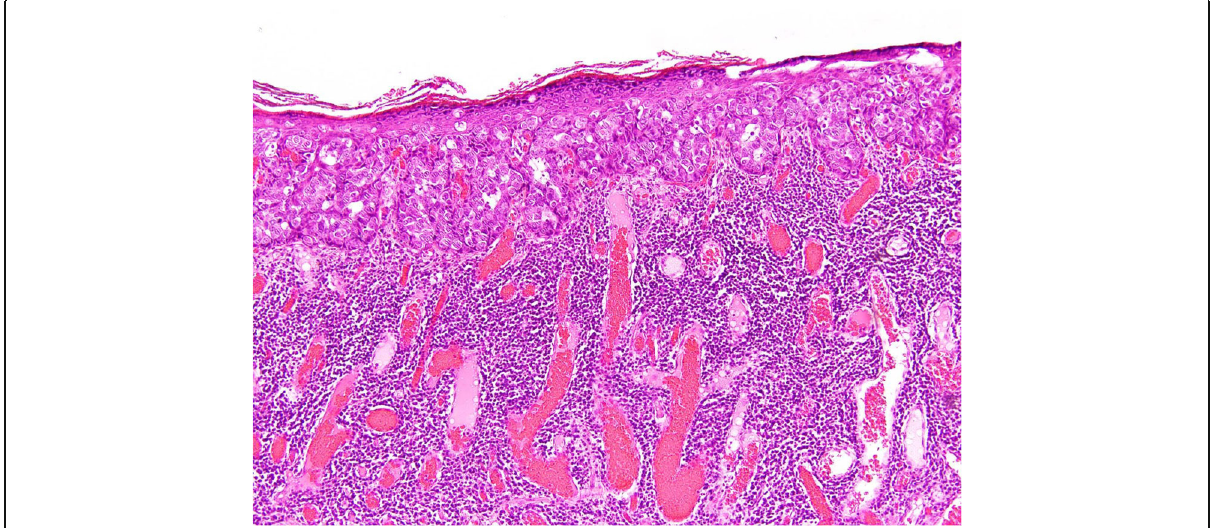
Fig. 4 Histological findings of the resected specimen (original magnification, × 10). Characteristic Paget cells were detected within the epidermis. No infiltration was